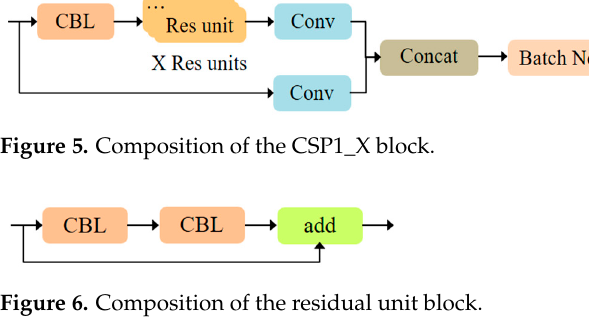
Figure 3. Composition of the “Focus” block .